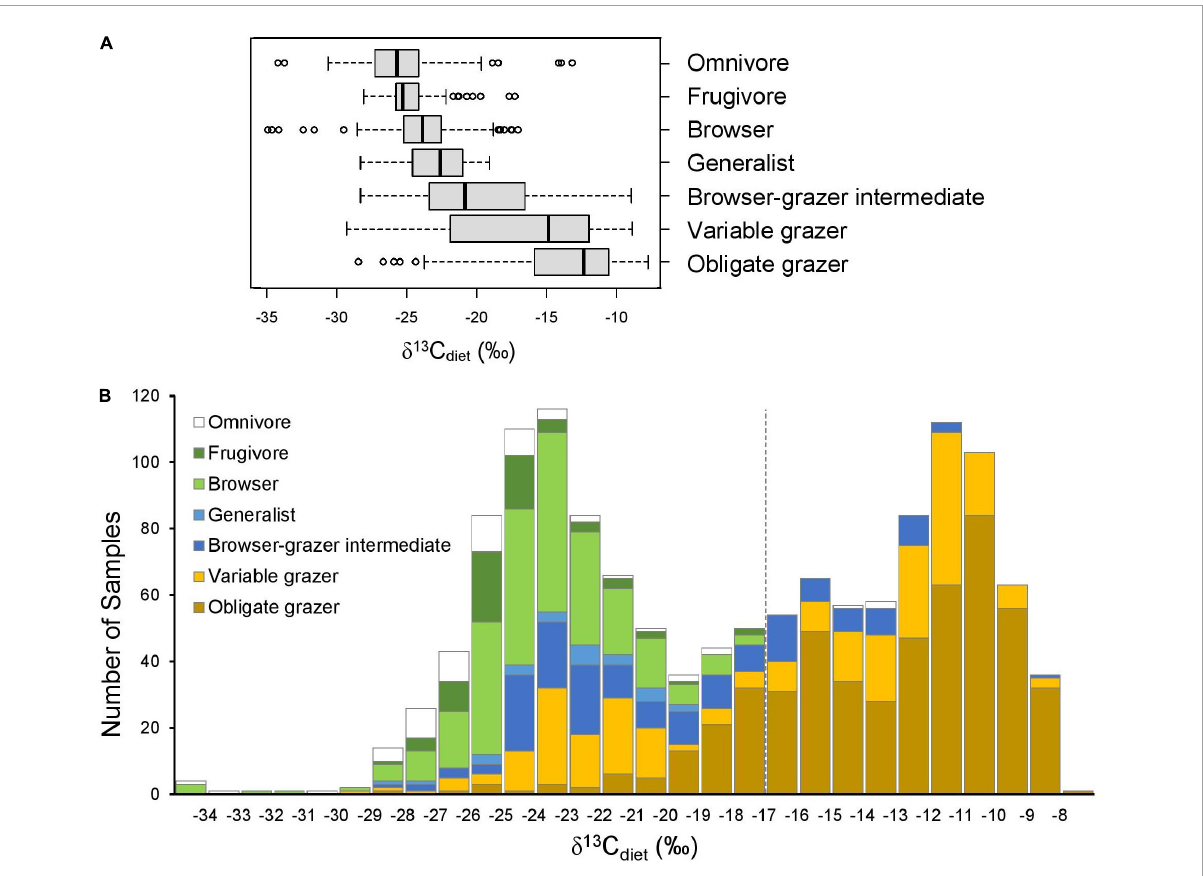
FIGURE2 Comparison of δ 13 C diet values among seven artiodactyl feeding categories. (A) Boxplots showing the (non-outlier) range (whiskers), first and third quartiles (box), median (vertical line), and outliers (circles) of δ 13 C diet values in each ecoregion. (B) Histogram of δ 13 C diet values of the feeding categories. Dashed line is the C 3 -C 4